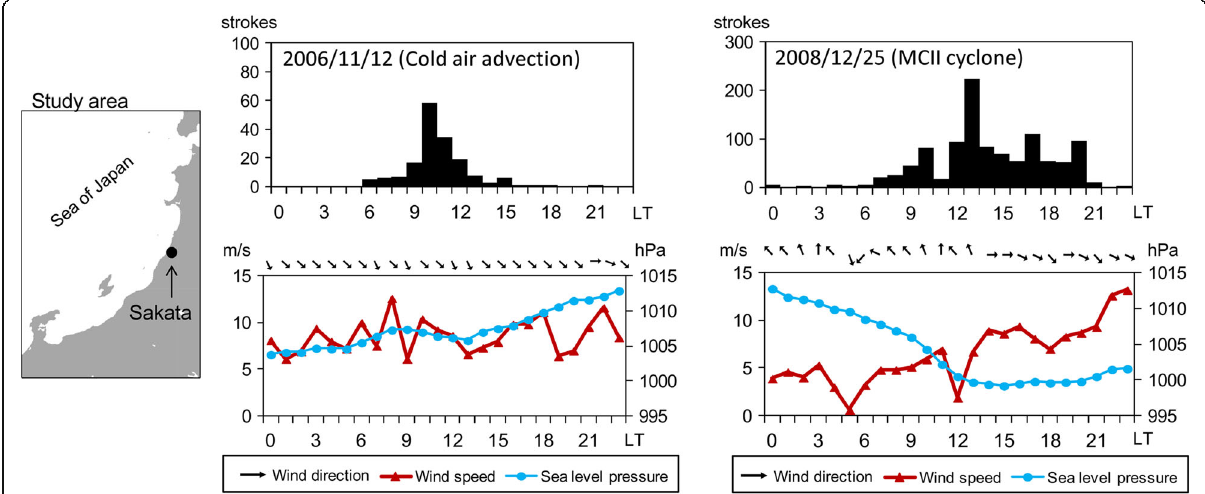
Fig. 9 Comparison of surface winds and sea-level pressure. Observations at Sakata (a JMA weather station) for cold air advection cases and MCII cyclone cases